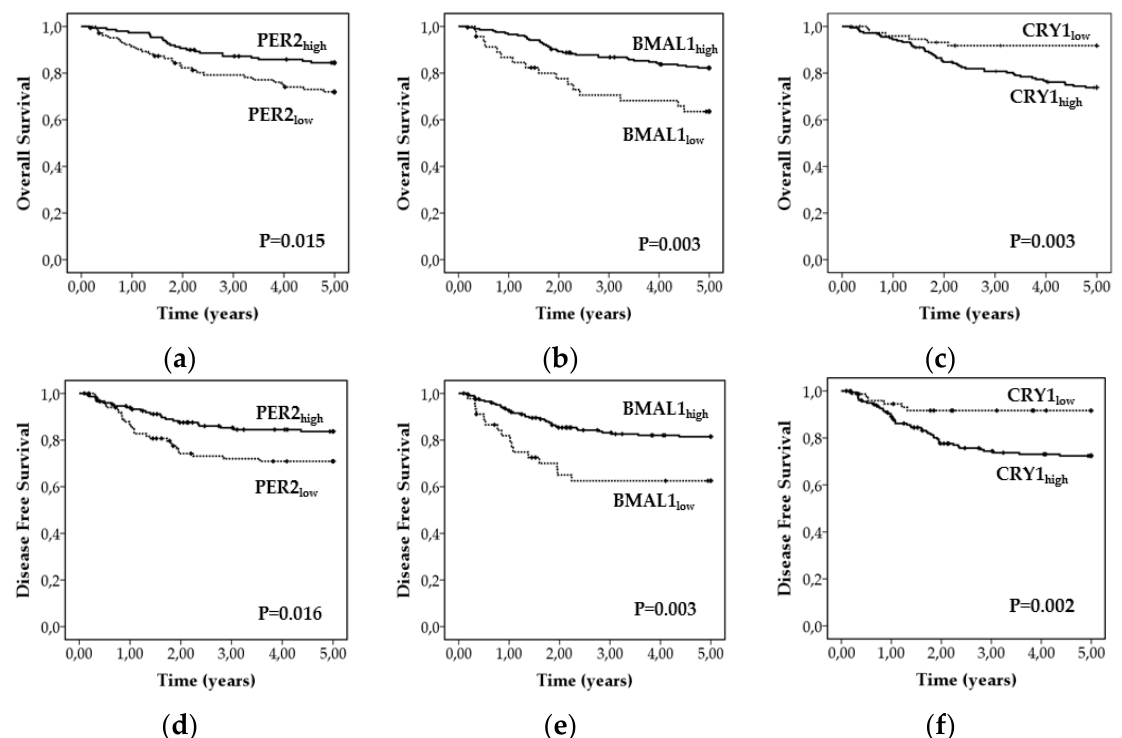
Figure 3. Kaplan–Meier curves depicting OS and DFS according to expression patterns of PER2 ( a , d ), BMAL1 ( b , e ) and CRY1 ( c , f ). p values were calculated with the log-rank test. Further, the multivariate Cox regression for survival analysis showed CRY1 and BMAL1 expression as independent prognostic factors for OS and DFS in patients with CRC (Table 10). Table 10. Multivariate Cox regression analysis of CRY1 and BMAL1 expression and clinicopatho- logic variables predicting survival in our cohort of CRC.